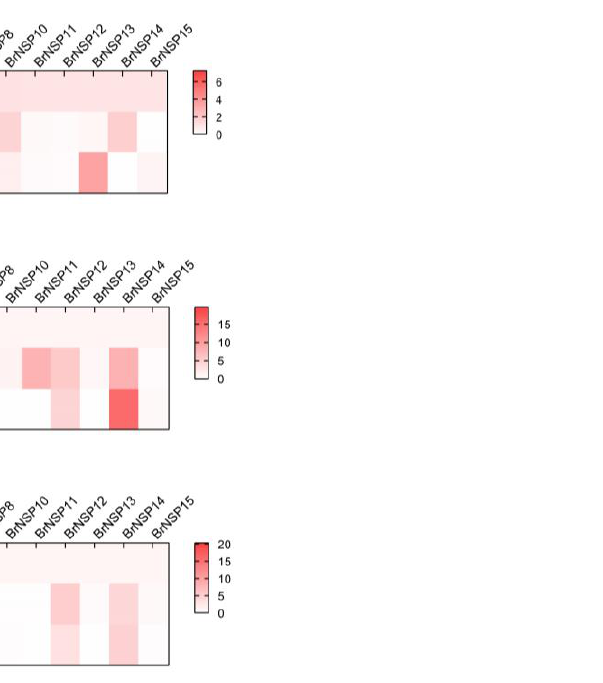
Figure 7. Expression of BrESPs and BrNSPs in three varieties of Chinese cabbage after insect attack.